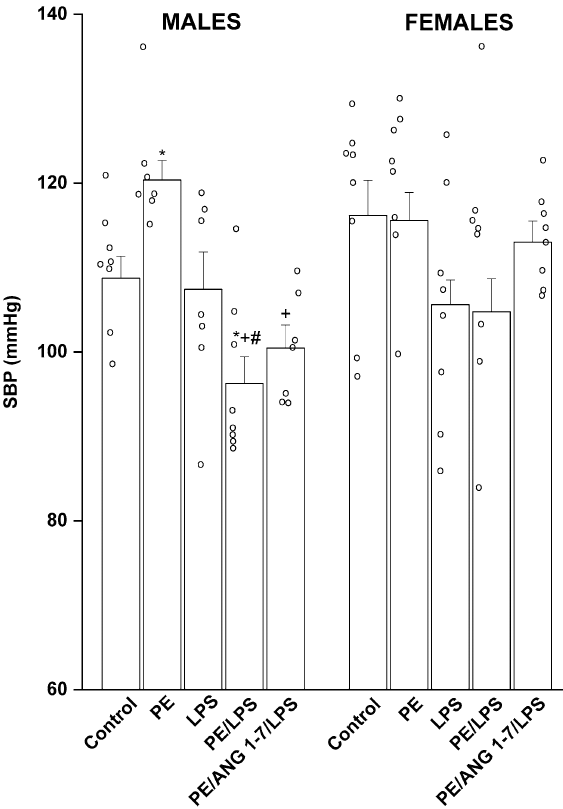
Figure 1. Tail cuff systolic blood pressure (SBP) and heart rate (HR) measurements 4 h post intraperitoneal injection of LPS (5 mg/kg) in adult male and female offspring of preeclamptic (PE) or non-PE dams. The influences of prenatal administration of Ang1-7 on SBP an HR are also shown. Values are expressed as means ± S.E.M of 6–8 measurements. The One-way ANOVA followed by the Tukey’s post hoc was utilized to measure statistical significance. *P < 0.05 vs. “Control”, + P < 0.05 vs. “PE”, # P < 0.05 vs. “LPS” in the same